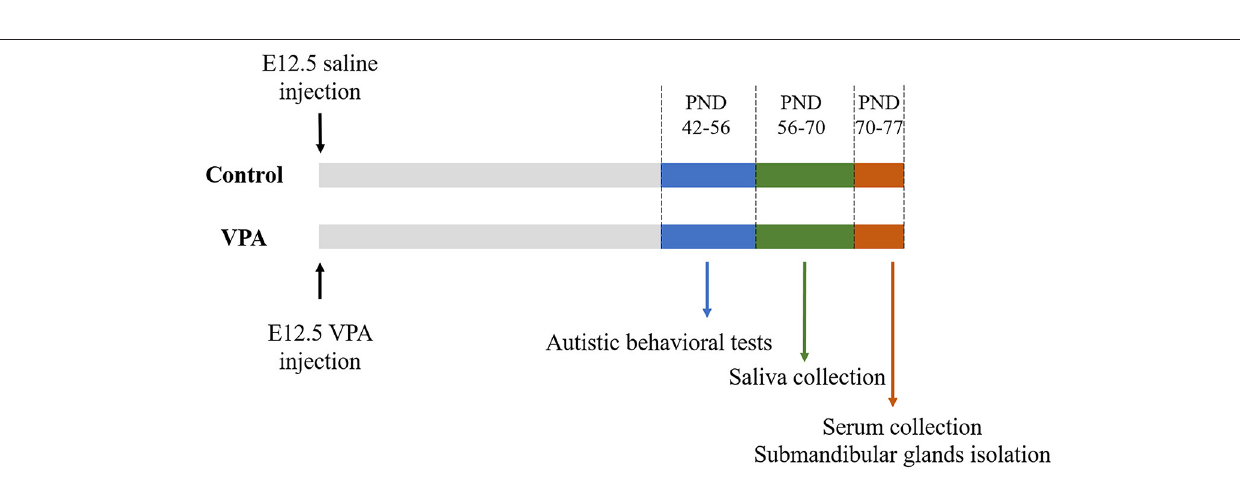
FIGURE 2 | The outline of animal experiments. VPA, valproate acid; E, embryonic day; PND, postnatal